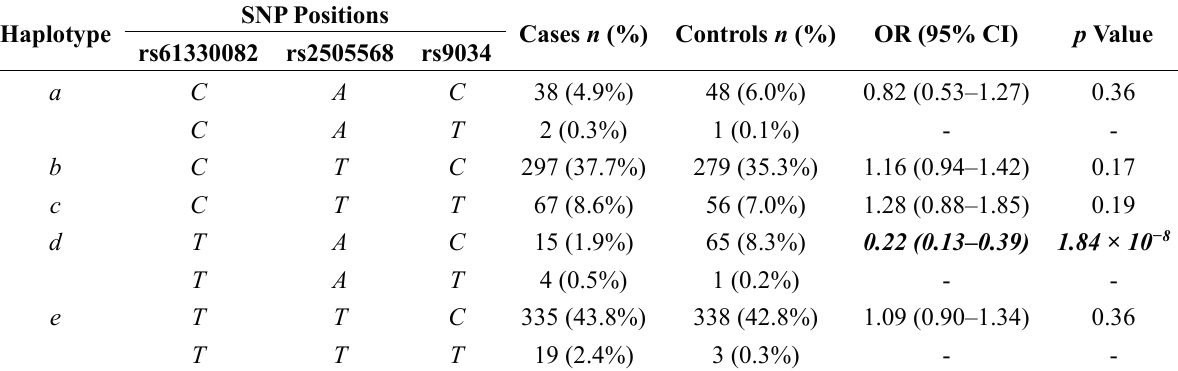
Table 3. Haplotype frequencies of NAMPT gene in the patients with DCM and in controls.